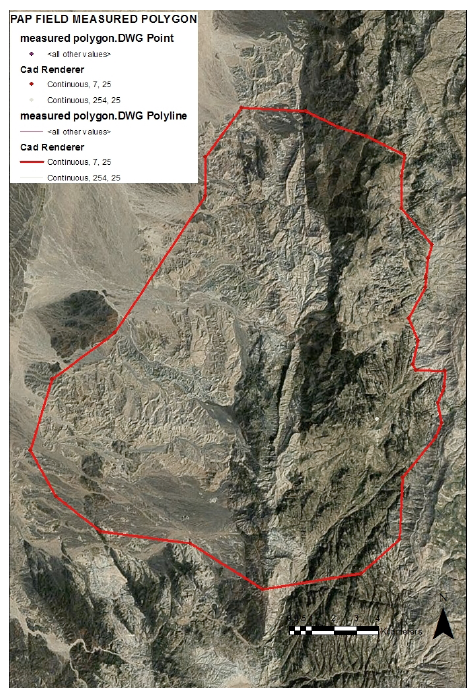
Figure 6: resulting polygon after mapping with the GPS. Figure 7: defined areas for boundary